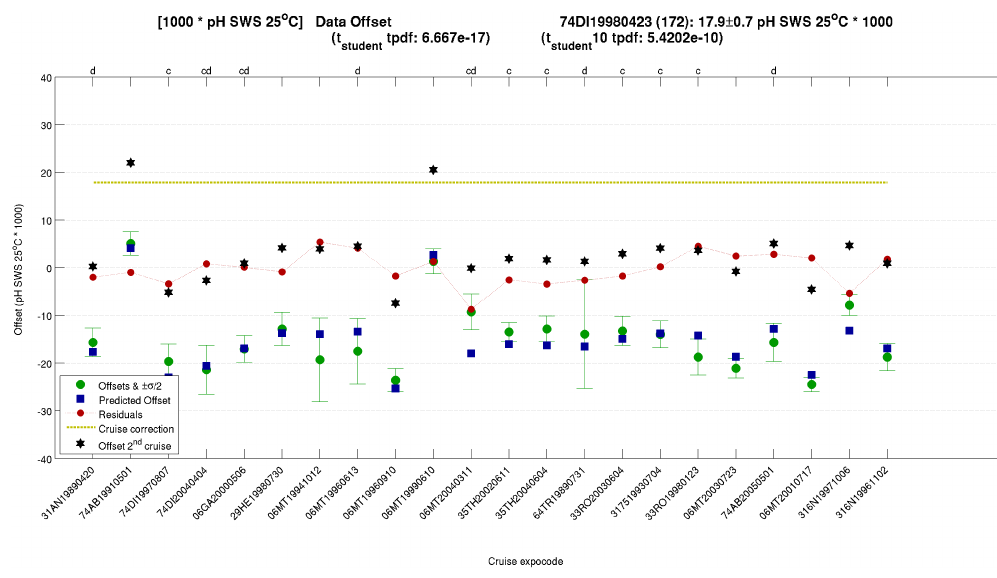
Figure 20. Cruise crossover information plot for 74DI19980423